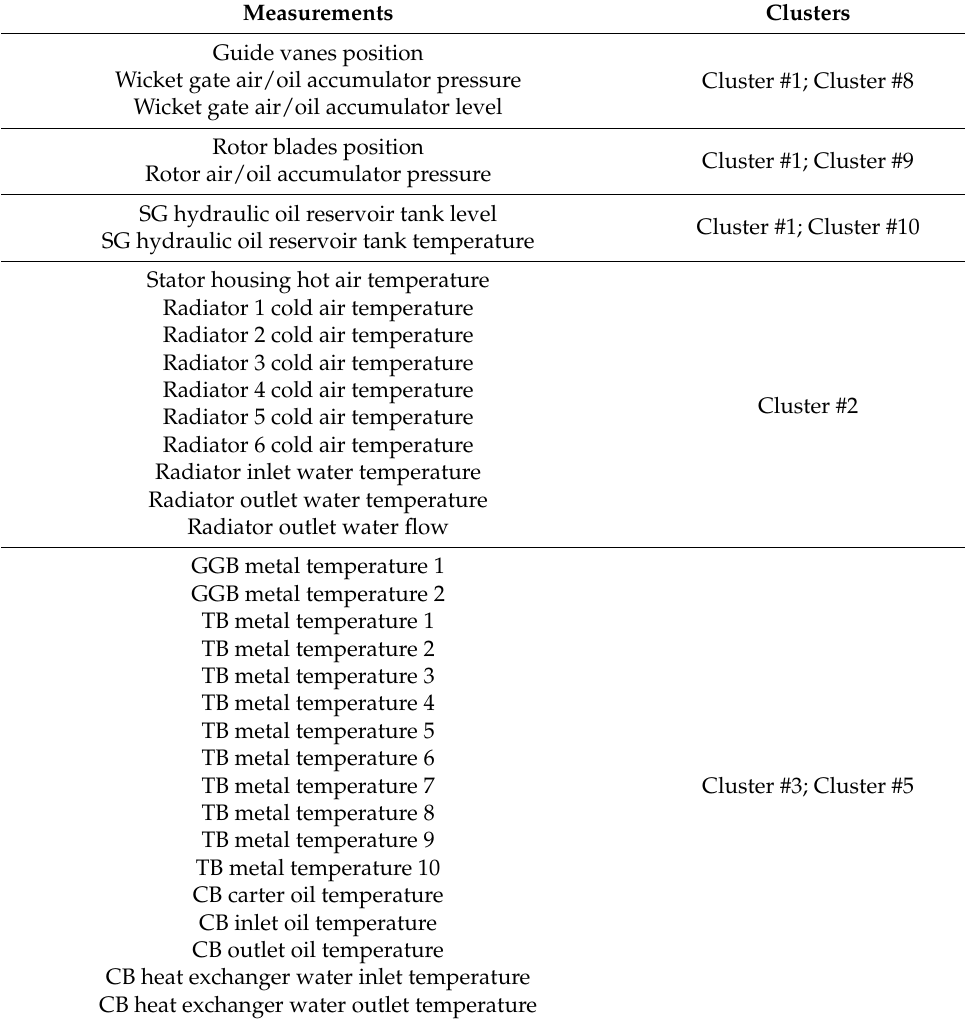
Table A1. Measurements and clusters relationship.